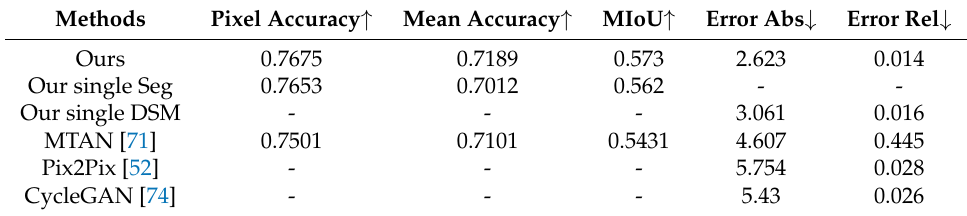
Table 1. Comparison of the results of current main methods in GeoNRW dataset.